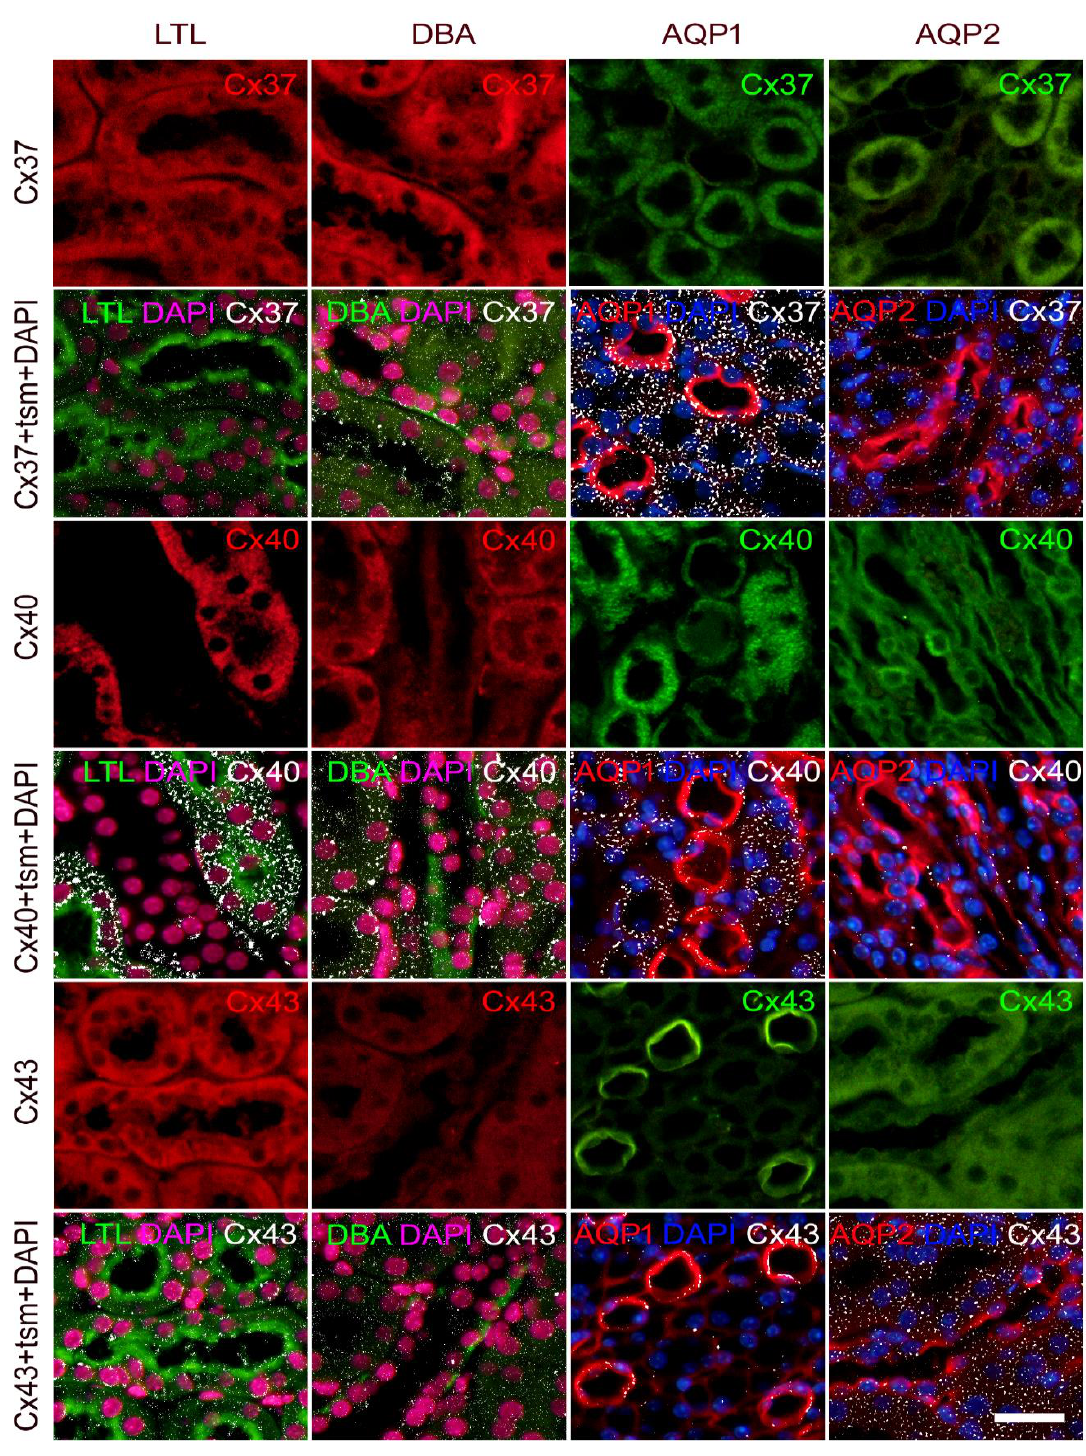
Figure 2. Colocalization of connexins 37, 40, and 43 with different tubular segment markers in the mice kidney. Sections from the wild-type mice. Lotus tetragonolobus lectin (LTL), proximal tubule marker (green; first column); Dolichos biflorus agglutinin (DBA), distal tubule marker (green; second column); aquaporin 1 (AQP1), thin descending loop of Henle marker (red; third column); aquaporin 2 (AQP2), collecting duct marker (red; fourth column). Nuclei were stained with DAPI (blue in third and fourth column; magenta—pseudocolorized in first and second column); tsm—tubular segment marker. Scale-bar = 20 µm, refers to all (magnification 400×).